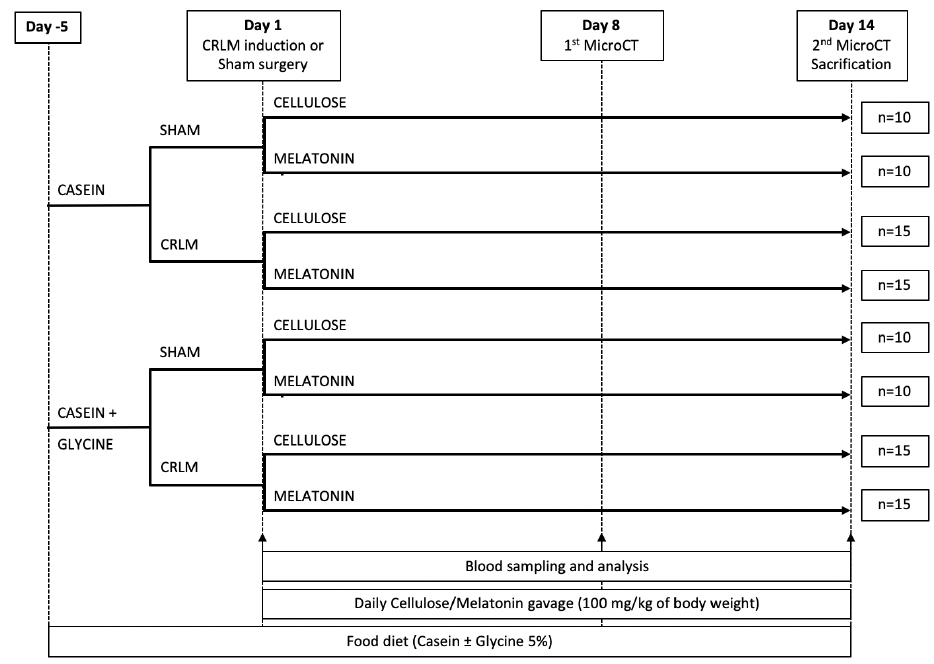
Figure 1. Experimental design. CRLM, colorectal cancer liver metastasis; CT, computed tomogra- phy.